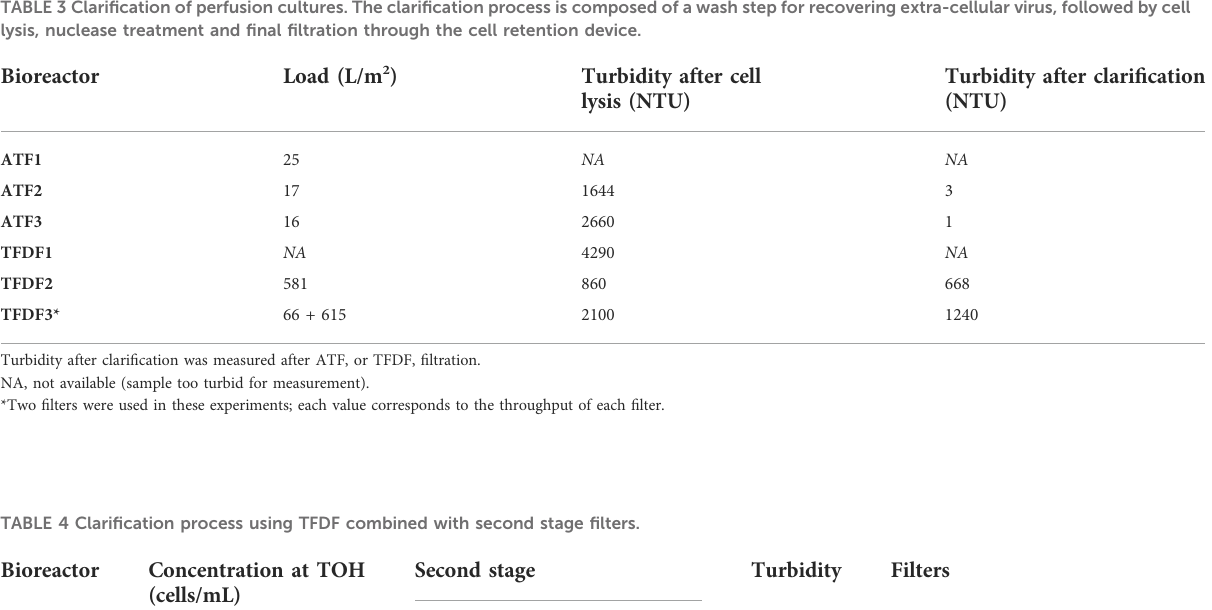
TABLE 3 Clari fi cation of perfusion cultures. The clari fi cation process is composed of a wash step for recovering extra-cellular virus, followed by cell lysis, nuclease treatment and fi nal fi ltration through the cell retention device. Bioreactor